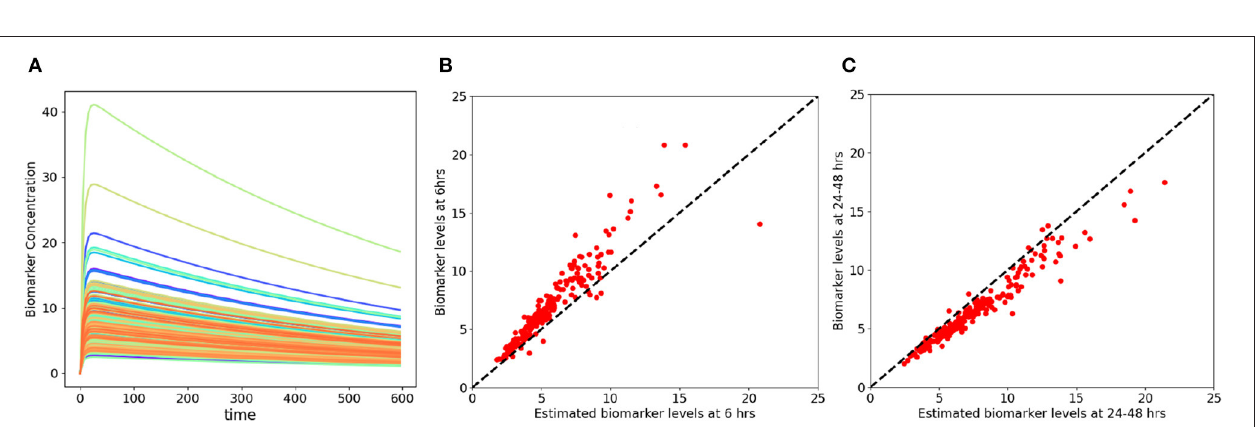
FIGURE 11 | Model estimated biomarker level at 6 and 24–48 h vs. actual biomarker level for each subject using available data set. (Top) x-axis corresponds to estimated C p at 6 h and y-axis corresponds to measured C p at 6 h. (Bottom) x-axis corresponds to estimated C p at 24–48 h and y-axis corresponds to measured C p at 24–48 h. Note that estimated levels for NF-L at 6 h are especially below measured levels.